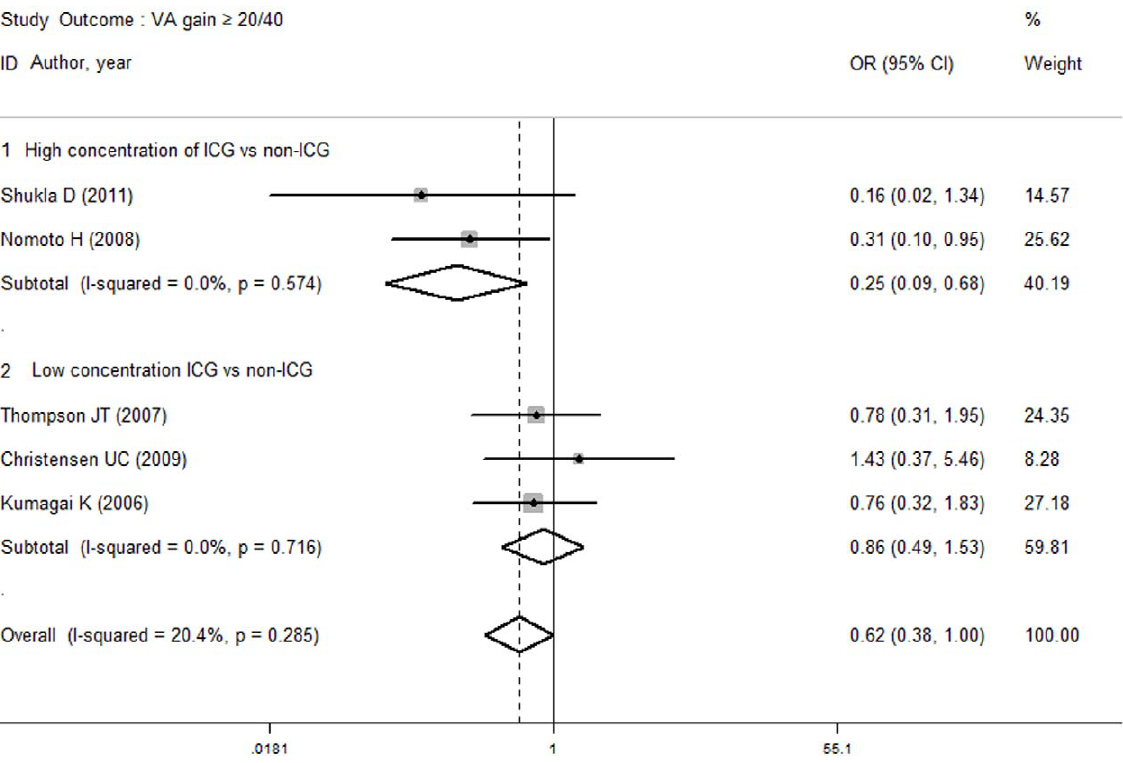
Figure 5. Subgroup analyses of outcome VA gain 20/40 in high and low concentration of ICG versus non-ICG group. The rate of VA gain $ 20/40 was lower in high concentration ICG group compared with non-ICG group, while no difference was observed between low concentration ICG and non-ICG group.